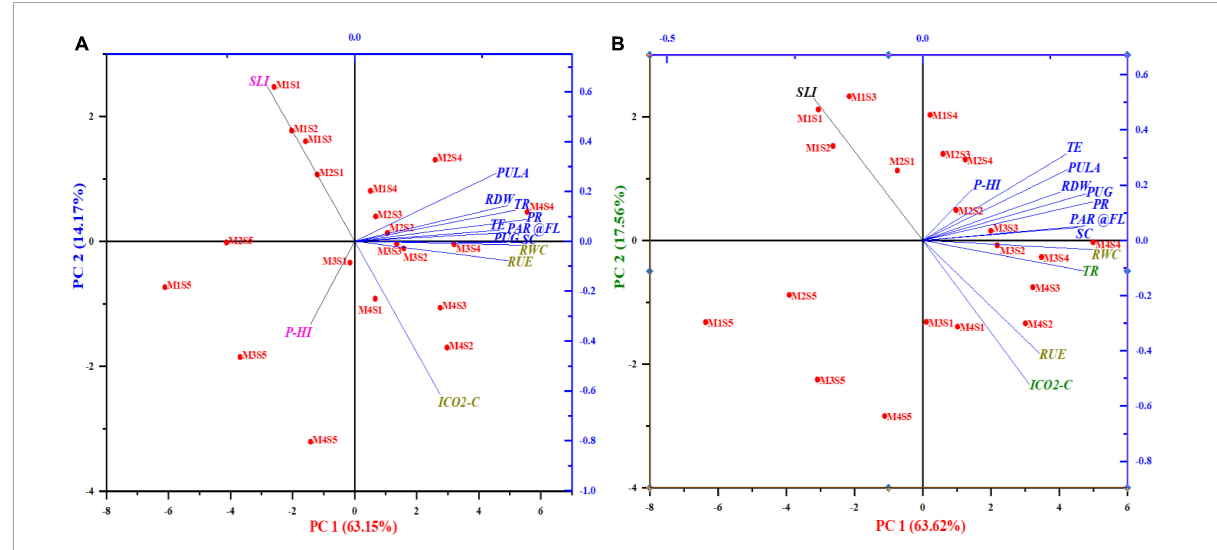
FIGURE10 Two-dimensional graphical biplot depicting the loadings and score plot formed by principal components 1 and 2 of photosynthetic indices, RUE, RWC, RDW, and grain-P uptake of maize (A) and wheat (B) . Percentage values on PC1 and PC2 indicate the respective variance explained by the first two PCA